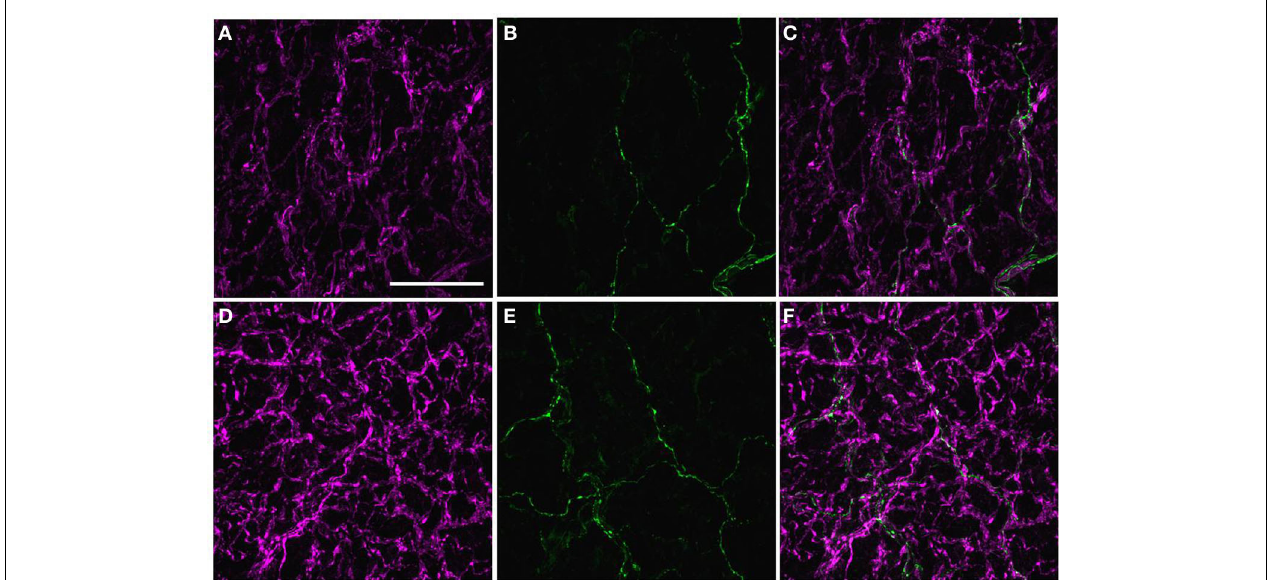
FIGURE 5 | Images displaying immunoreactivity (IR) for neuropeptide Y (NPY)(magenta; A,D) and calcitonin gene-related peptide (CGRP) (green; B,E) and the combination of both markers (C,F) in the perivascular nerve plexus of a plantar metatarsal artery (PMA) from a control rat (A–C) and a streptozotocin (STZ)-treated rat (D–F) that received a low dose of insulin